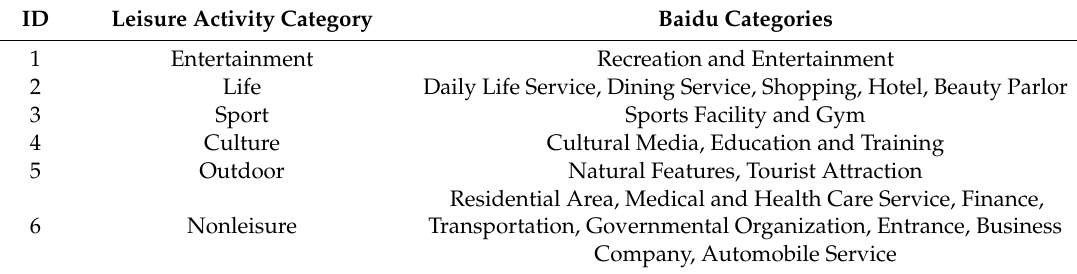
Table 2. Reclassification of the